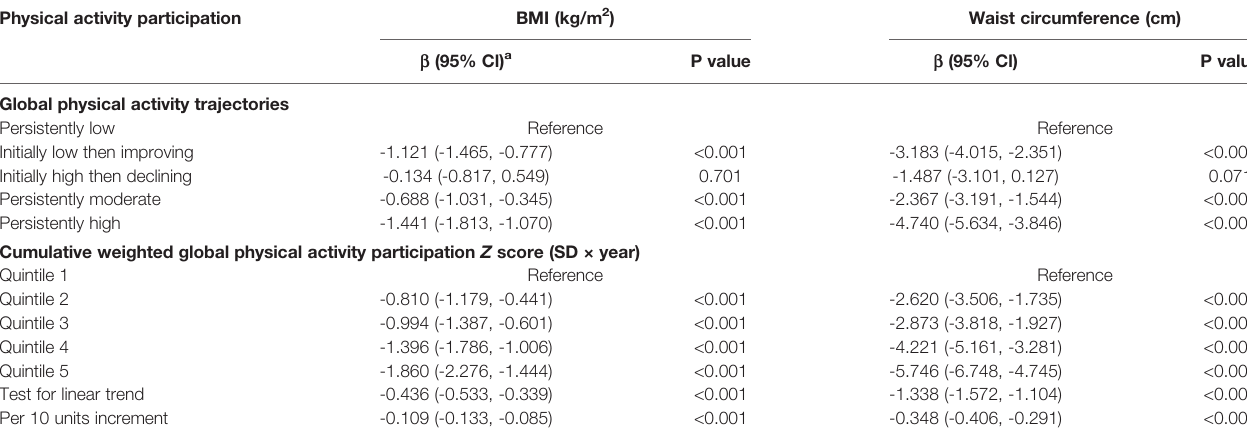
TABLE 2 | Association of long-term physical activity participation on subsequent obesity assessed by BMI and waist circumference. Physical activity